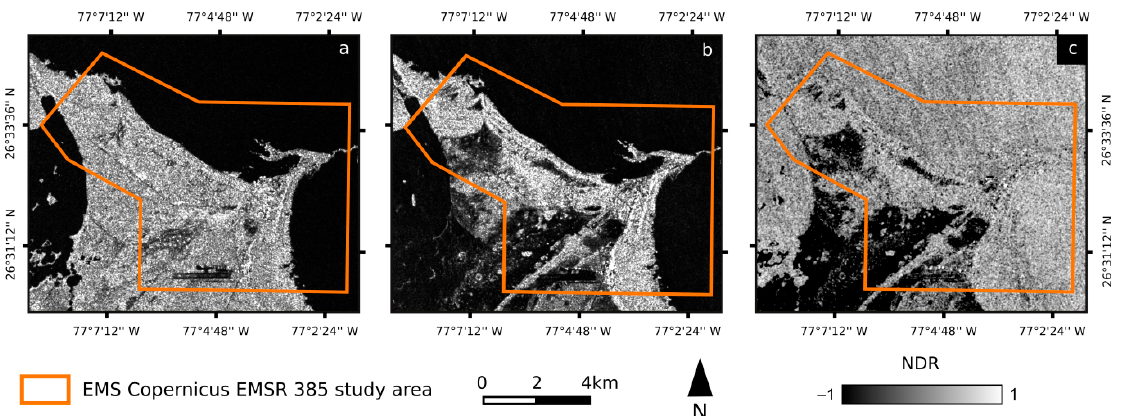
Figure 6. SAR and NDR images for Marsh Harbour area. ( a ) SAR image from 21 August 2019; ( b ) SAR image from 2 September 2019; ( c ) NDR.